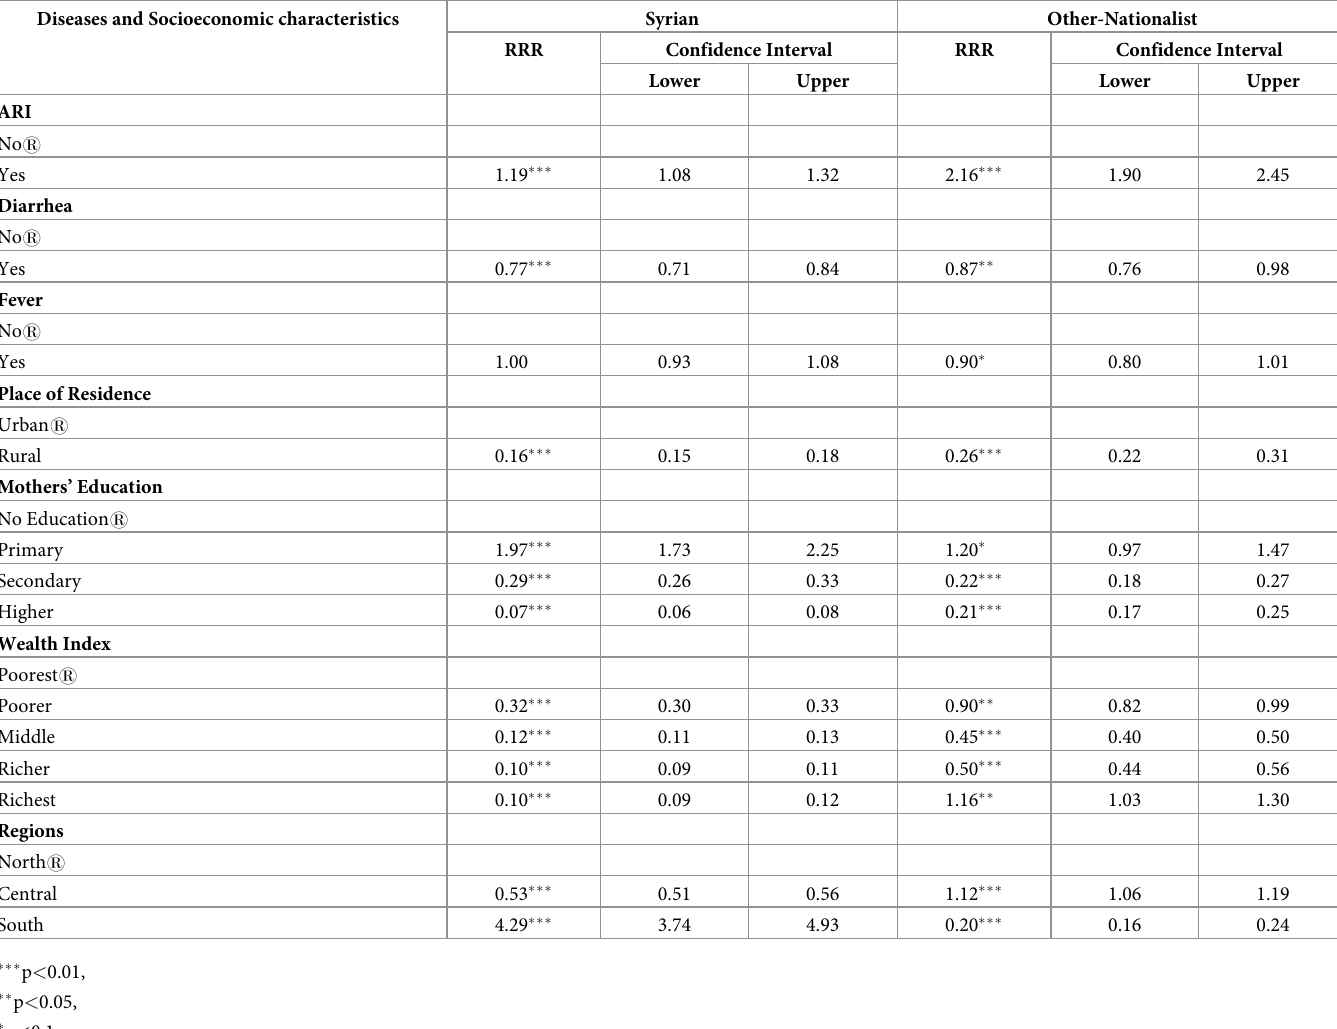
Table 5. Multinomial regression results of nationalities showing relative risk ratio among under-five children in Jordan (2017–18) by its diseases and socioeconomic characteristics. Diseases and Socioeconomic